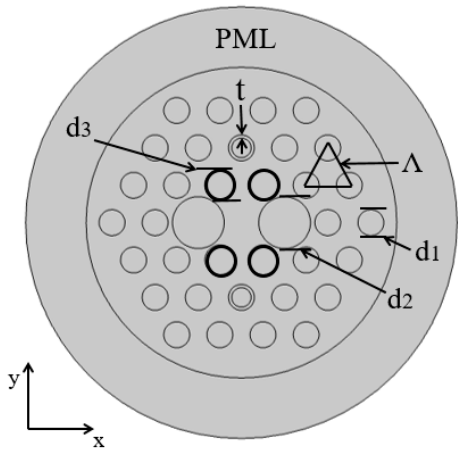
Figure 1. Cross-sectional view of the proposed PCF filter.